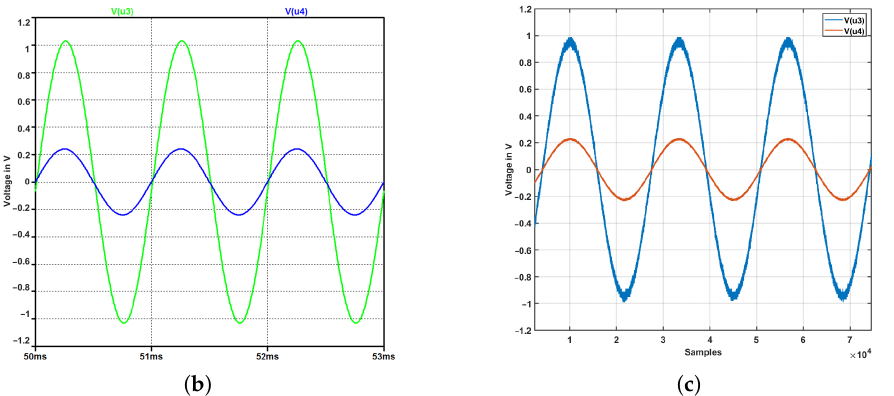
Figure 7. I-U measurement module: ( a ) sensing structure ( b ) simulation results, and ( c ) implementa- tion results.